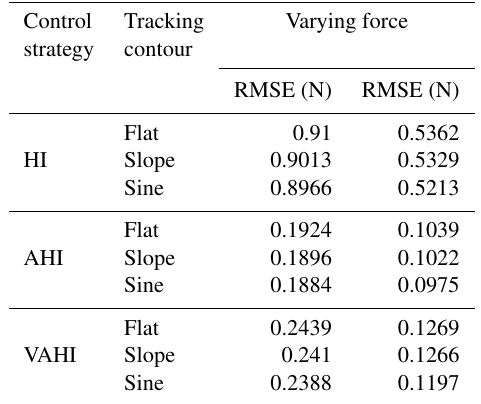
Table 1. Comparison of hybrid impedance (HI), adaptive hybrid impedance (AHI), and VAHI schemes in the steady force tracking